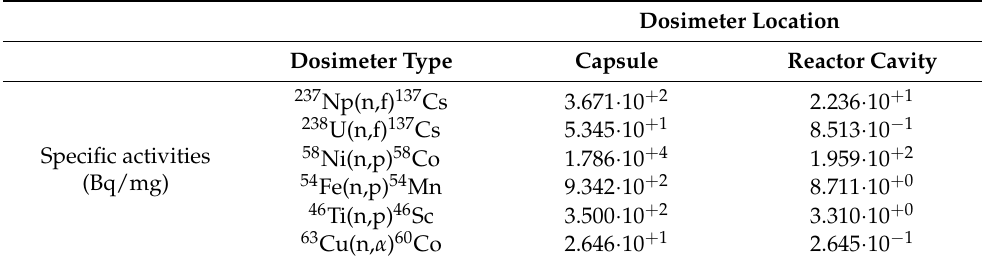
Table 1. Specific activities measured in the equatorial plane, at the end of cycle no. 9, for the dosimeters placed in the capsule of the surveillance program and in the cavity of the H.B. Robinson-2 reactor [11].